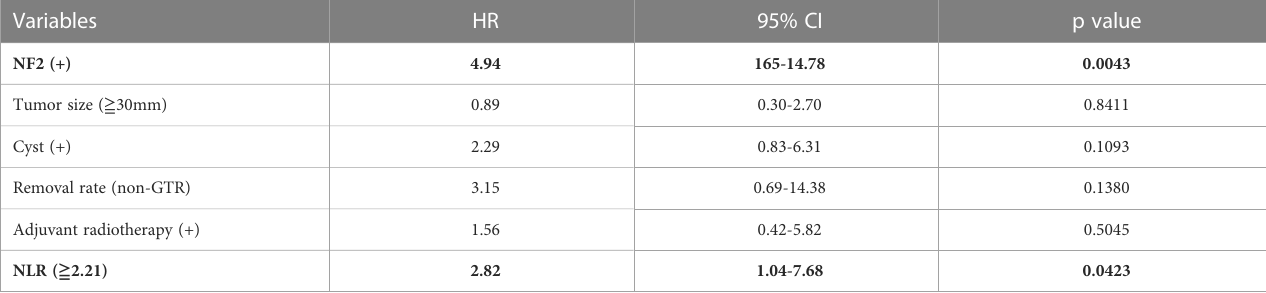
TABLE 3 Multivariate Cox proportional hazards regression analysis.